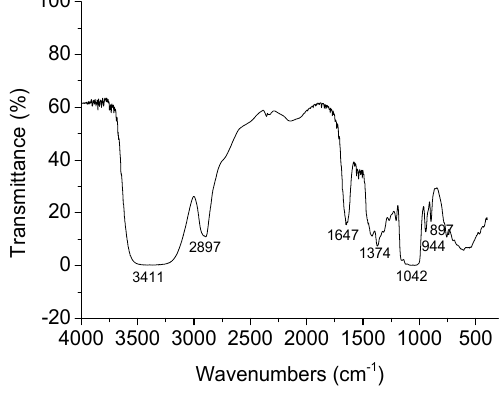
Figure 2. FT ‐ IR spectrum of TSP. Figure 2. FT-IR spectrum of